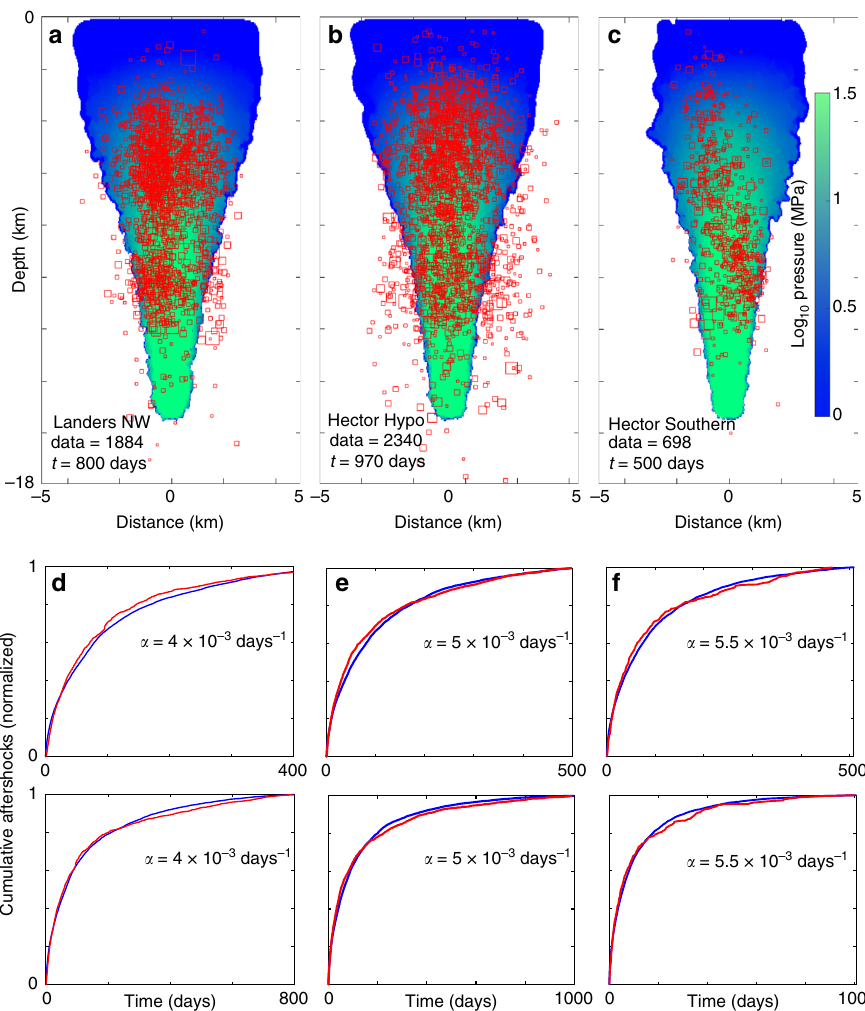
Fig. 6 Model results from Landers NW, Hector Hypo and Hector Southern. ( a – c ) Comparison of computed pressure fi elds with “ data = ” measured hypocenters for three different dilatant sections of the Landers and Hector Mine earthquakes. ( d – f , e ) Comparison of data (red) and model results (blue) for two different time windows, demonstrating again that dramatic differences in productivity results in similar permeability recovery times. See Supplementary Fig. 6 for the corresponding Omori fi